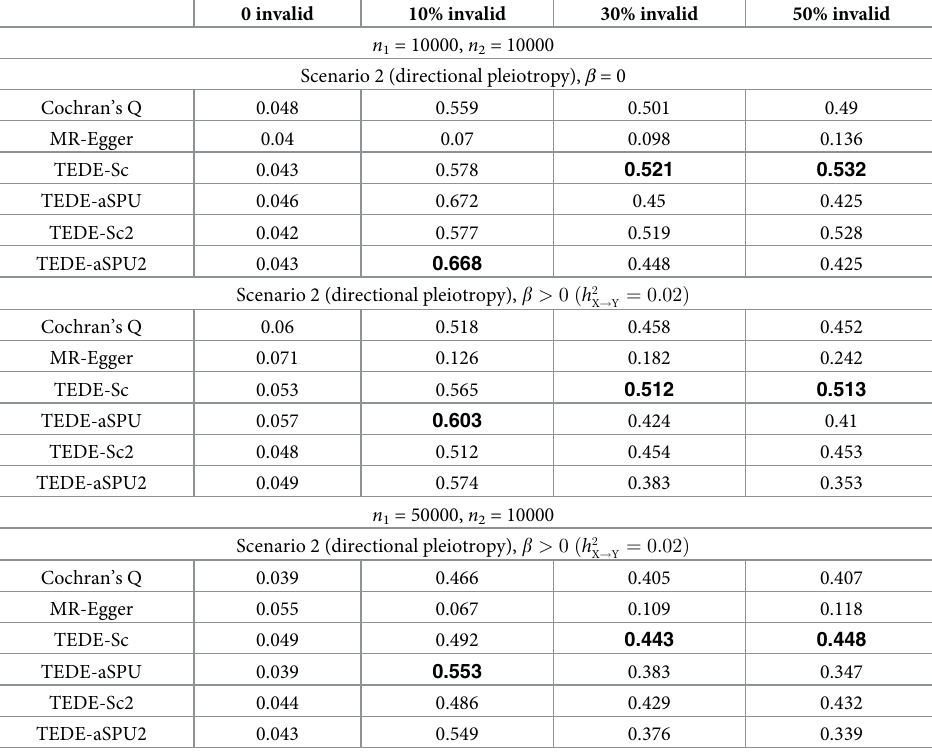
Table 2. Rejection rates (type I error when there is 0 invalid IV; power otherwise) for testing horizontal pleiot- ropy. Independent variants. 1000 iterations. p = 100, n 1 = 10000, n 2 = 10000. 0